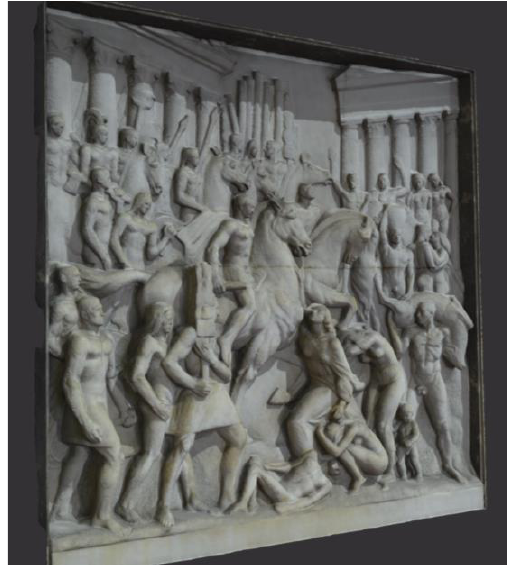
Fig. 23. Example of 3D model accessible using the